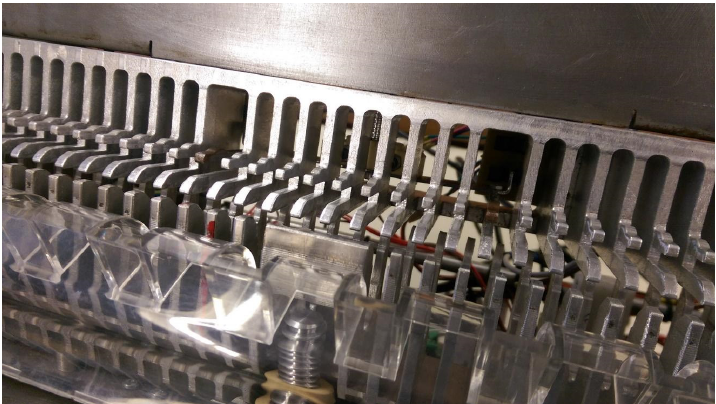
Figure 8. Pins used in the document height adjustment mechanism placed at the height for binding with a large spine.